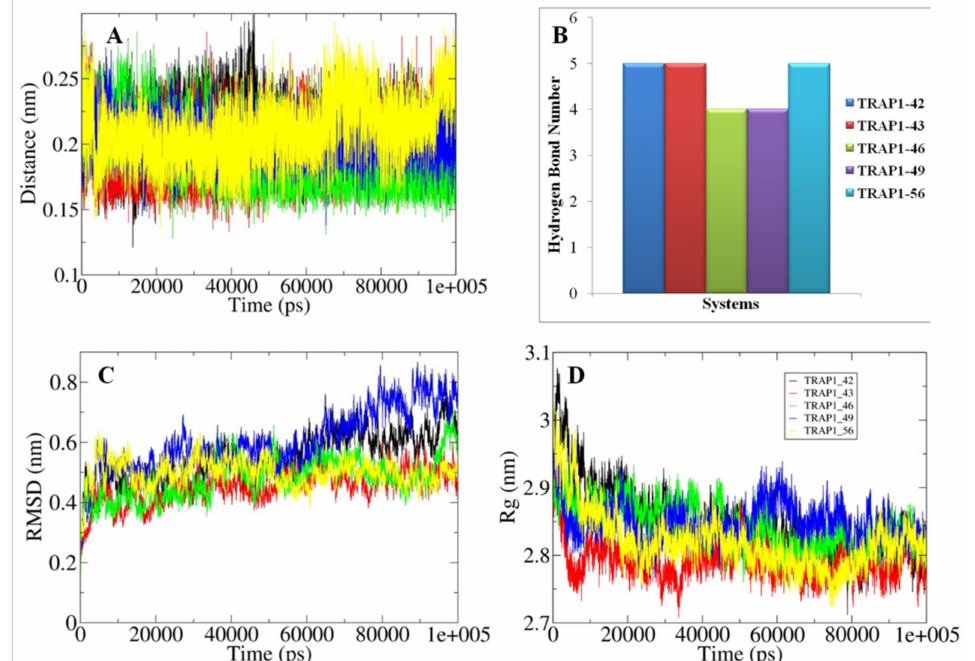
Figure 11. The graphical representation of MD simulation-based generated parameters with ( A ) shows the calculated distance changes between the docked TRAP1 and inhibitors. ( B ) Illustrating the variation observed in the hydrogen bonding during the 100 ns time scale. ( C ) Highlighting the changes in the RMSD values observed during MD simulations. ( D ) Projecting the variations in the structural compactness of the docked systems in terms of the radius of gyrations. (Black: TRAP1-42, Red: TRAP1-43, Green: TRAP1-46, Blue: TRAP1-49, Yellow: TRAP1-56).